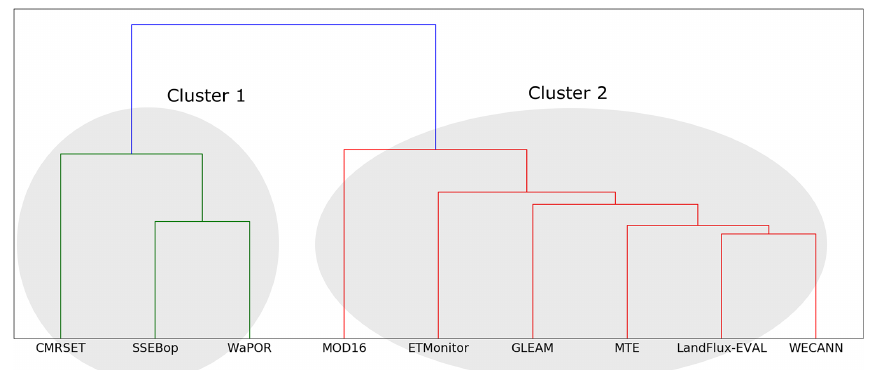
Figure 13. Cluster analysis based on the pairwise Euclidean distance between each pixel for each ET product to assess overall similarity between data